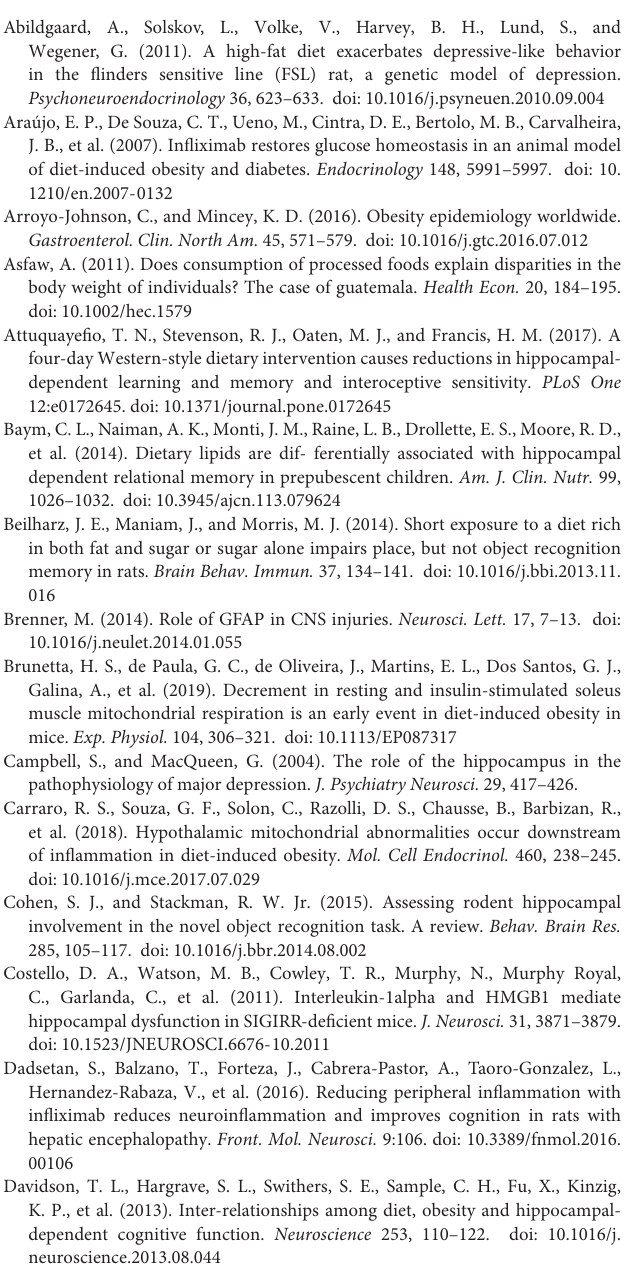
Figueiredo, C. P., et al. (2020). Red wine consumption mitigates the cognitive impairments in low-density lipoprotein receptor knockout (LDLr-/-)